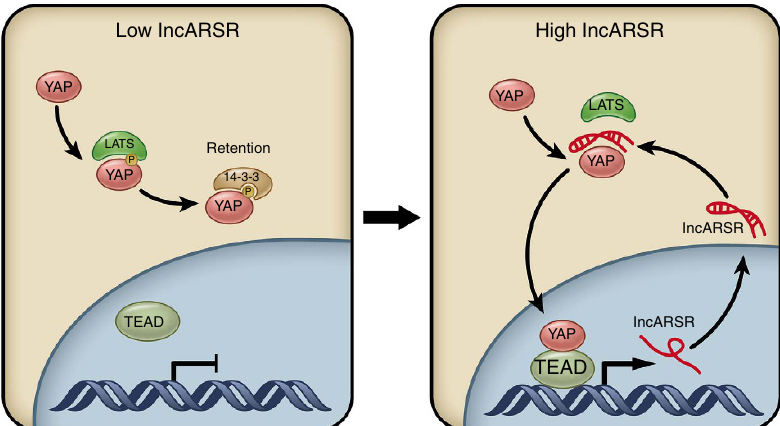
Figure 9 | Schematic diagram of lncARSR–YAP signaling circuit in renal T-ICs. lncARSR overexpression impedes LATS-YAP interaction to facilitate the nuclear translocation of YAP, which in turn transactivates lncARSR expression, forming a feed-forward loop to promote the expansion of